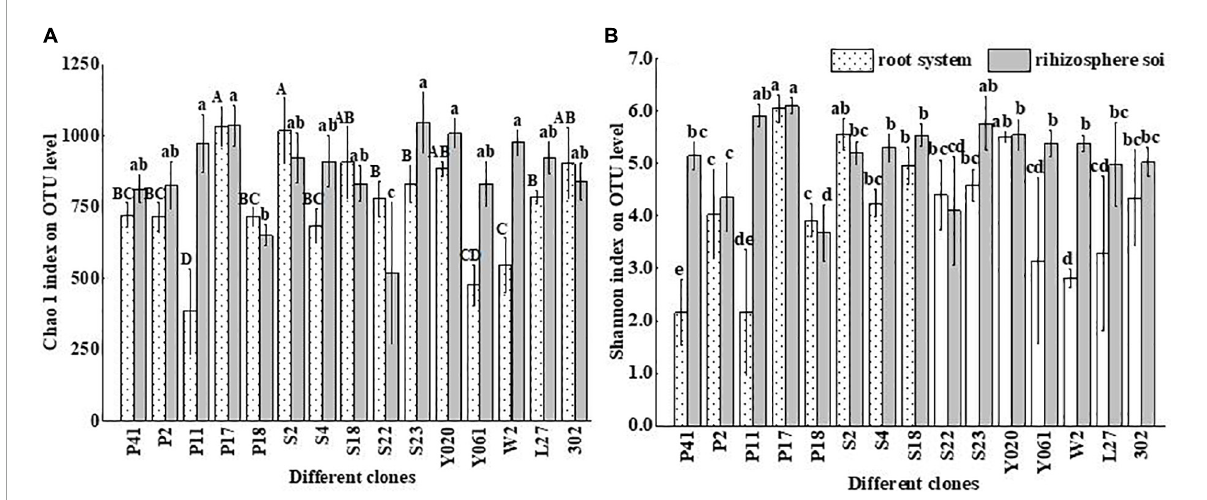
FIGURE5 The alpha diversity index of AMF in different clones of Chinese fir plantations (A,B) . Bars (means ± standard error) accompanied by the same lowercase letter(s) are not significantly different at the 5% probability level. The capital letters in the panel indicate that the difference is very significant ( P < 0.01), lowercase letters indicate significant differences ( P < 0.05), the same below. On the horizontal axis, S-NR represents bulk soil, R-represents root system, S-represents rhizosphere soil, and the subsequent number indicates